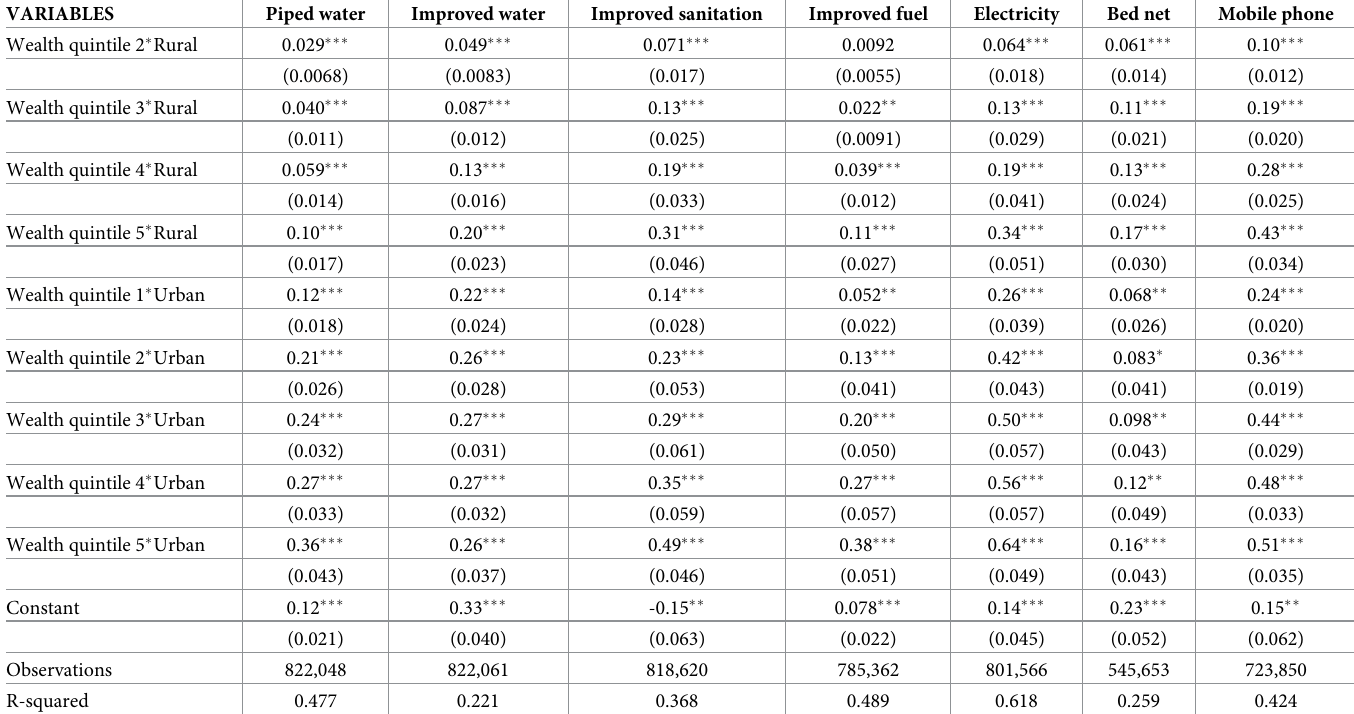
Table 6. Pooled multivariable regression estimates of the association between wealth-urbanization interactions and EHA access.